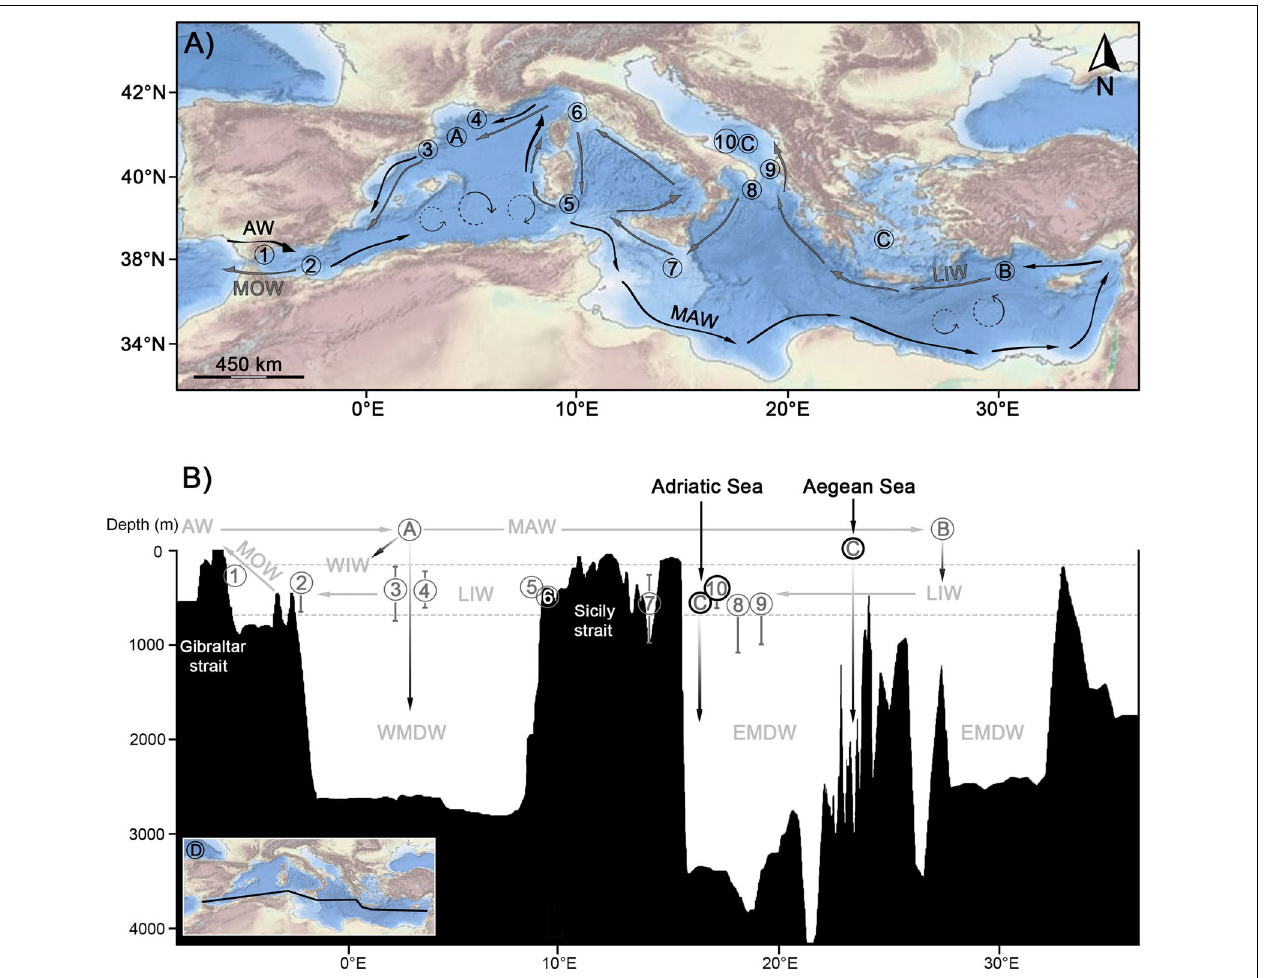
FIGURE 13 | (A) Bathymetric map of the Mediterranean Sea, with all CWC provinces (numbers) evaluated represented alongside a simplified schematic representation of its water masses circulation and formation (Letters). (B) Vertical profile of the Mediterranean Sea with all CWC provinces depth ranges represented alongside a simplified schematic representation of its water masses circulation (arrows) and formation (letters). The whiskers on each number represent the depth range of occurrence for each CWC province according to Chimienti et al. (2019) with additional data for the Corsica Channel from Angeletti et al. (2020) and for the Catalan Margin from the De Leo et al. (2019) and Puig et al. (2019). 1: Strait of Gibraltar and western Alboran (SoG-wA); 2: eastern Alboran (eA); 3: Catalan Margin (CM); 4: Gulf of Lions (GoL); 5: South of Sardinia (sS); 6: Corsica Channel (CC); 7: Maltese waters (M); 8: Santa Maria di Leuca (SMdL); 9: Albanian coasts (AL);